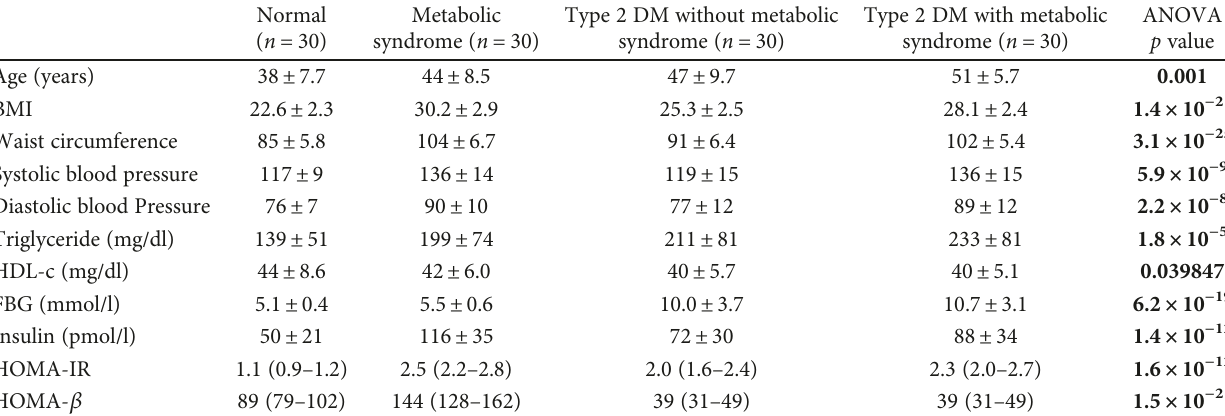
Table 1: Characterization of subjects included in the